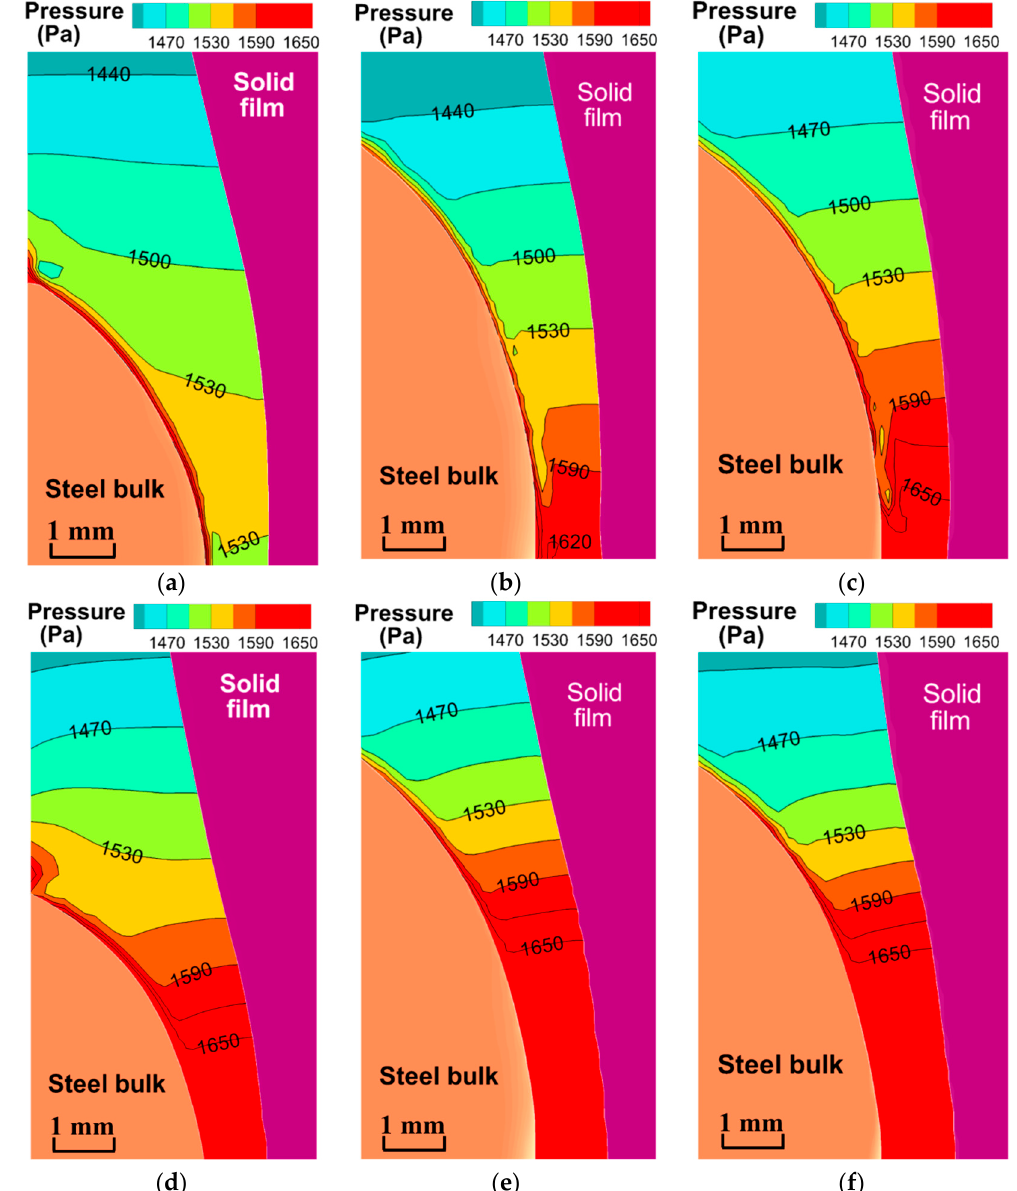
Figure 5. Distribution of pressure in the slag channel: ( a ) t 1 , α = 0.2, ( b ) t 1 , α = 0.5, ( c ) t 1 , α = 0.8, ( d ) t 2 , α = 0.2, ( e ) t 2 , α = 0.5, and ( f ) t 2 , α = 0.8.